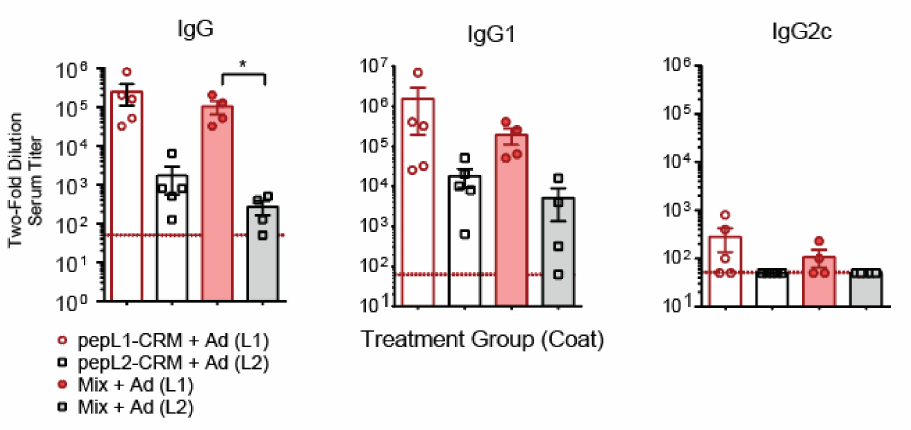
Figure 6. Antigen-specific immune response to pepL1 and pepL2-based vaccine in C57BL/6 mice. Serum titers of IgG subclasses (IgG, IgG1, IgG2c) from mice immunized with pepL1-CRM, pepL2- CRM, or Mix. Titers were measured by diluting sera 1:50 and then diluting two-fold; data is shown as the reciprocal titer. Red line indicates minimum positive titer (1:50). Kruskal-Wallis with Dunn’s post-hoc test. * p <